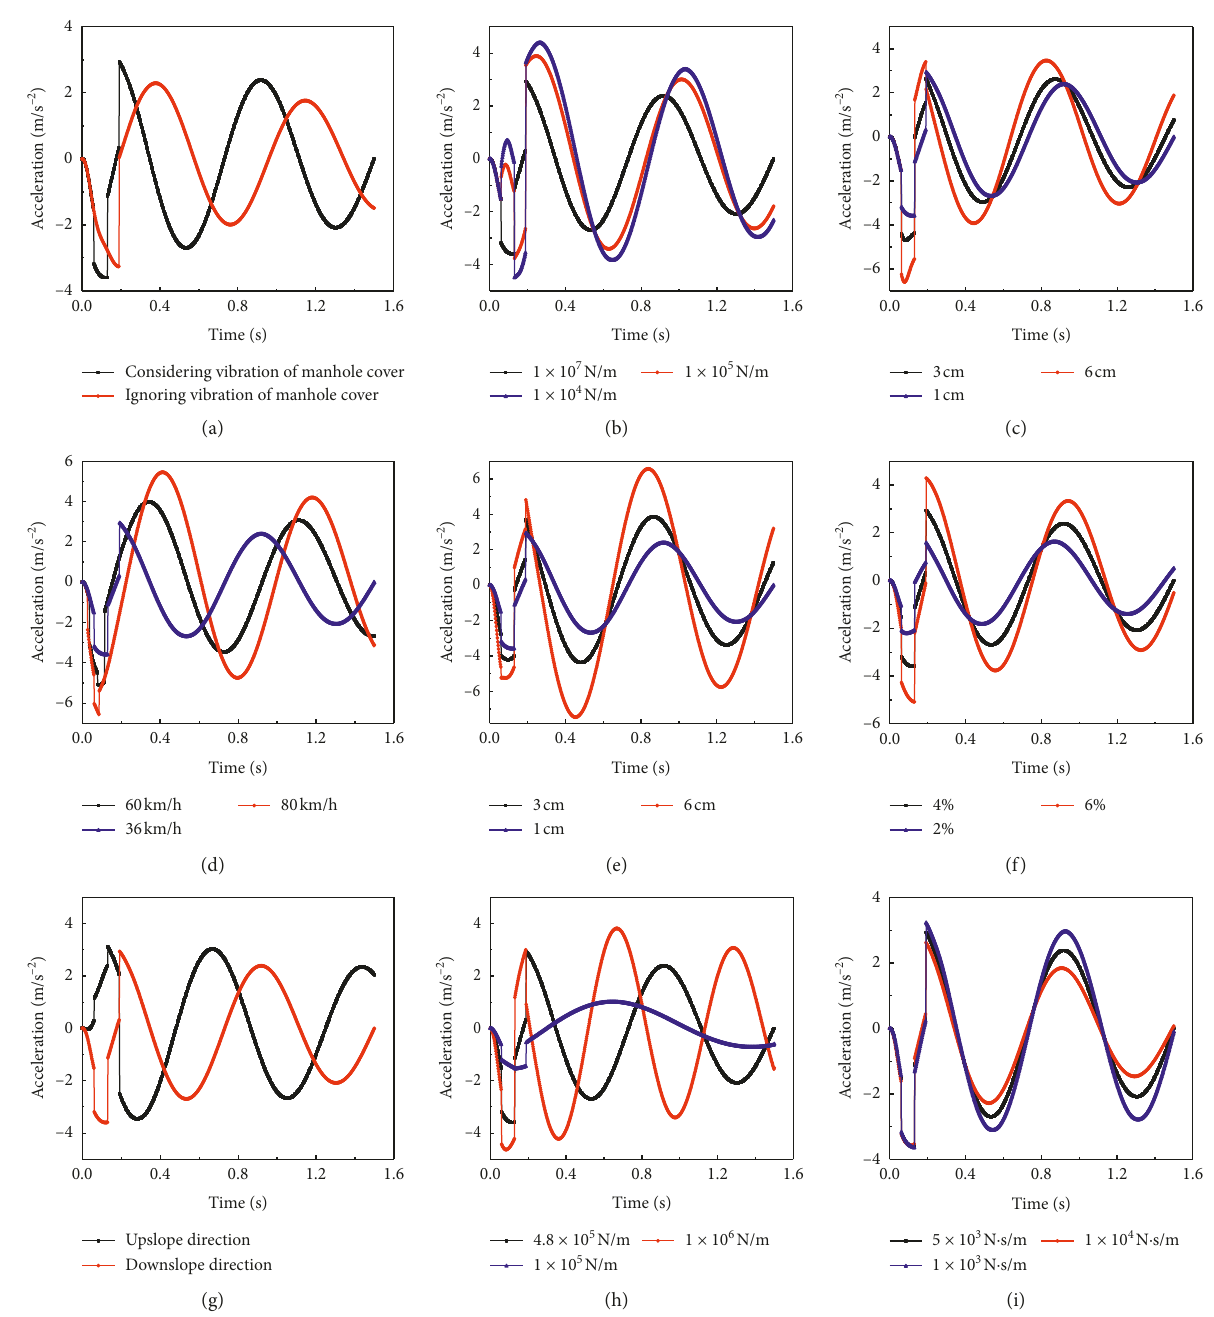
Figure 3: Driver acceleration changes with time under the influence of different factors. (a) Vibration of the manhole cover. (b) Stiffness of the manhole cover. (c) Subsidence of manhole. (d) Driving speed. (e) Height difference. (f) Longitudinal slope value. (g) Driving direction. (h) Tire stiffness coefficient. (i) Tire damping (5) Figure 3(e) and Table 3 show that driver’s maximum acceleration increased and the driver’s driving com- fort decreased gradually as height difference caused by damage to the pavement around the manhole in- creased. As the height difference increased from 1 cm to 3 cm and 6 cm, the driver’s maximum acceleration was 4.4 m/s 2 and 7.5 m/s 2 , an increase of 25.0% and 108.3%, respectively. Furthermore, when the height difference increased from 2 cm to 3 cm and 5 cm, the